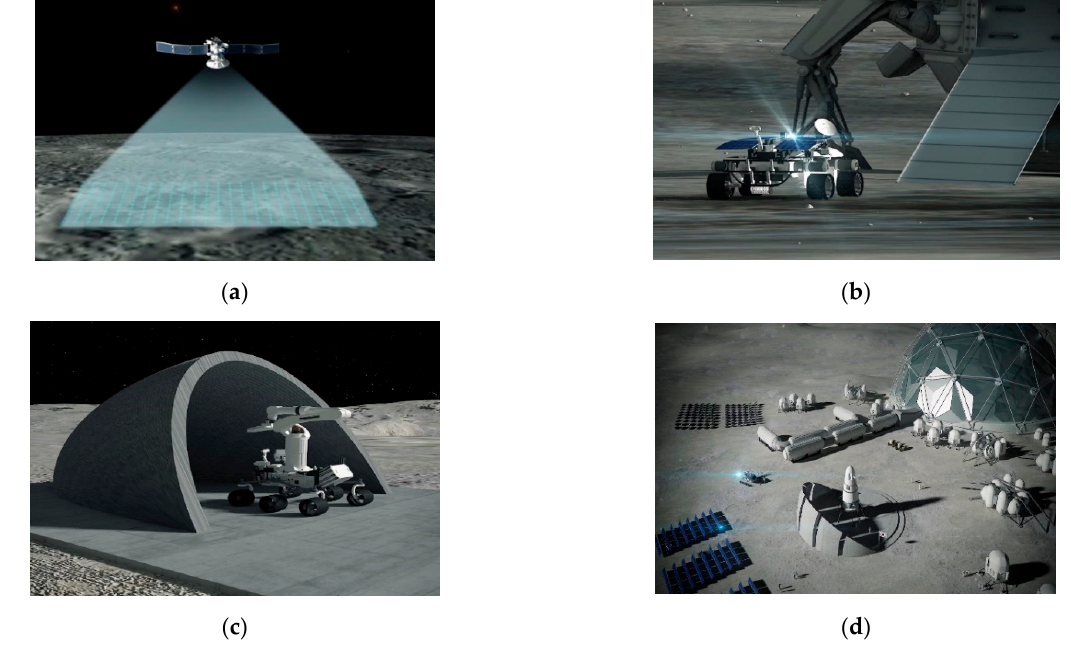
Figure 1. Conceptual process of a planetary construction: ( a ) construction site selection with a planetary orbiter; ( b ) construction site investigation with rover; ( c ) site preparation and infrastructure emplacement with a construction robot; ( d ) base and ISRU facility construction for human presence.